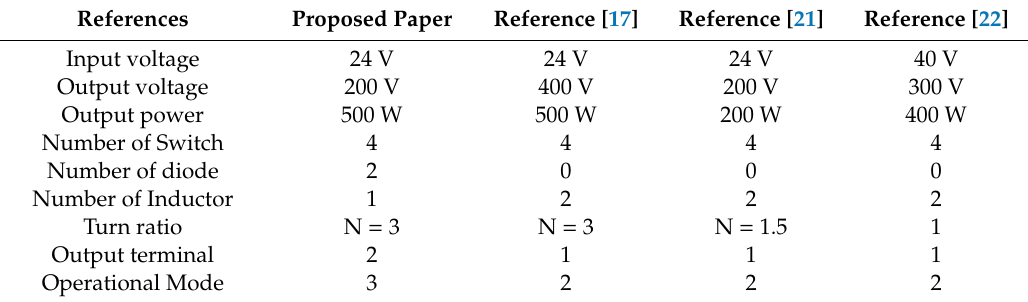
Table 1. Comparison of the proposed converter with previously reported bidirectional